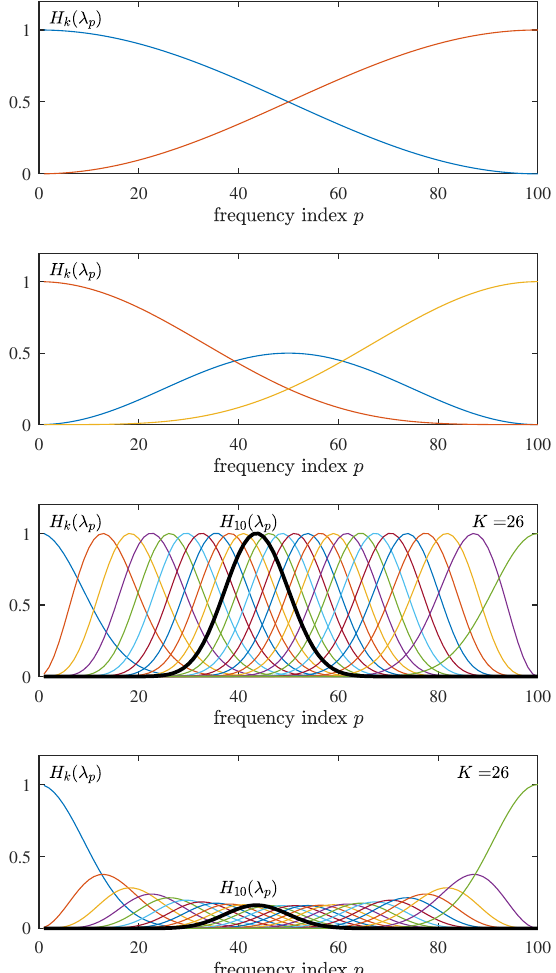
Figure 5. The spectral domain transfer functions H k ( λ p ) , for a circular undirected and unweighted graph (classical analysis), p = 1,2, . . . , N , k = 0,1, . . . , K − 1, that correspond to the terms of the binomial form for K =